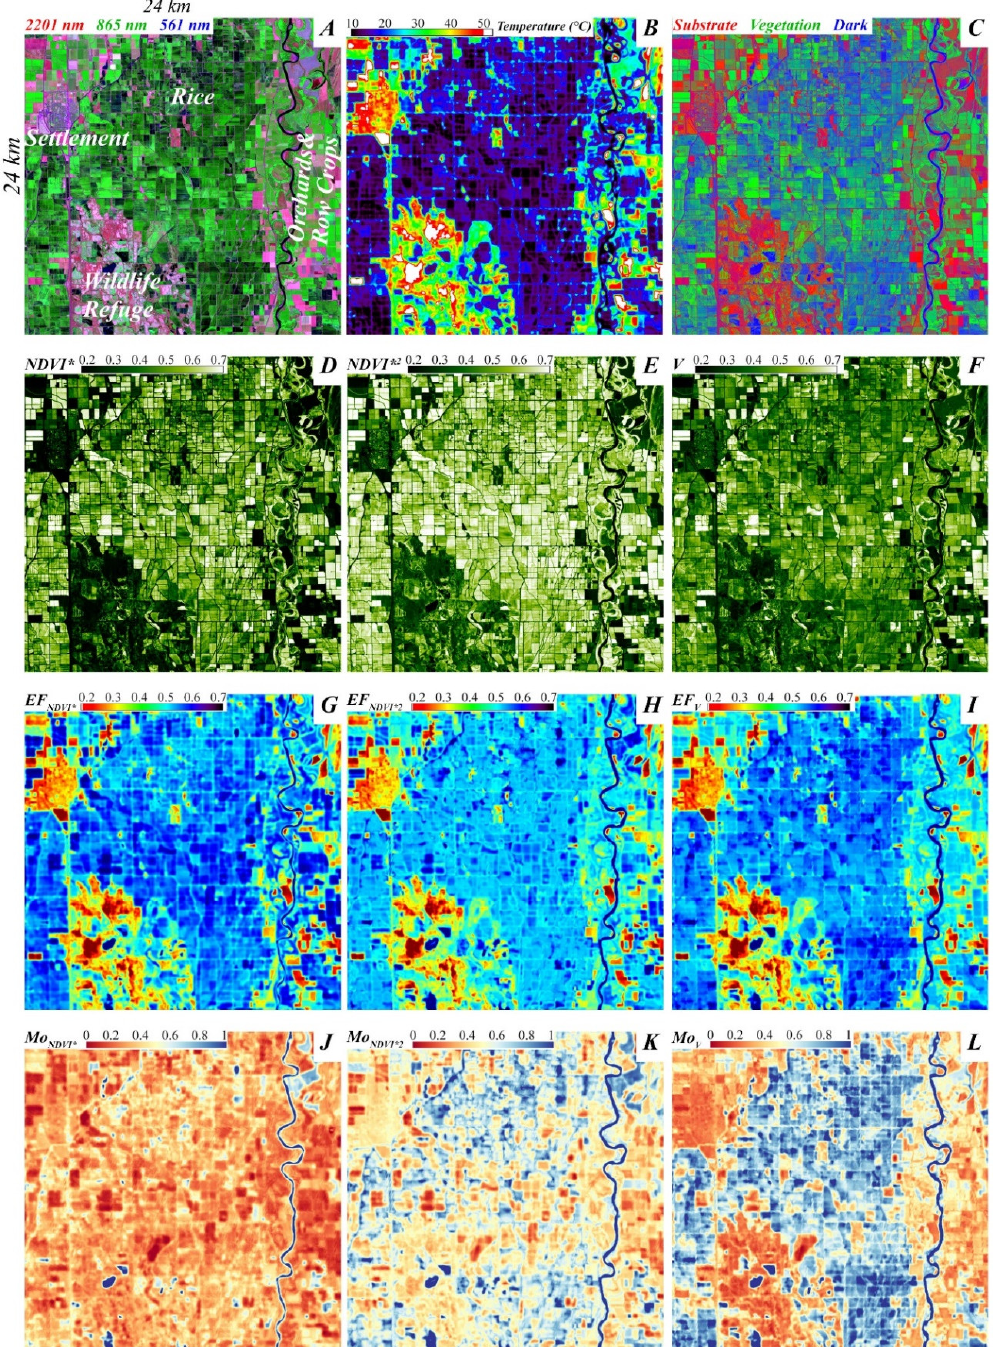
Figure 8. Example ET comparison. Landsat 8 collected coincident optical (A) and thermal (B) imagery on June 19, 2013. SVD fraction image (C) reveals substantial spatial heterogeneity in agricultural and preserved lands. NDVI* (D) and NDVI* 2 (E) images show substantial differences from each other and from V (G). EF estimates using the three vegetation metrics (G-I) show similar overall patterns, but notable differences within agricultural areas. Differences in Mo (J-L) estimates are even more profound.